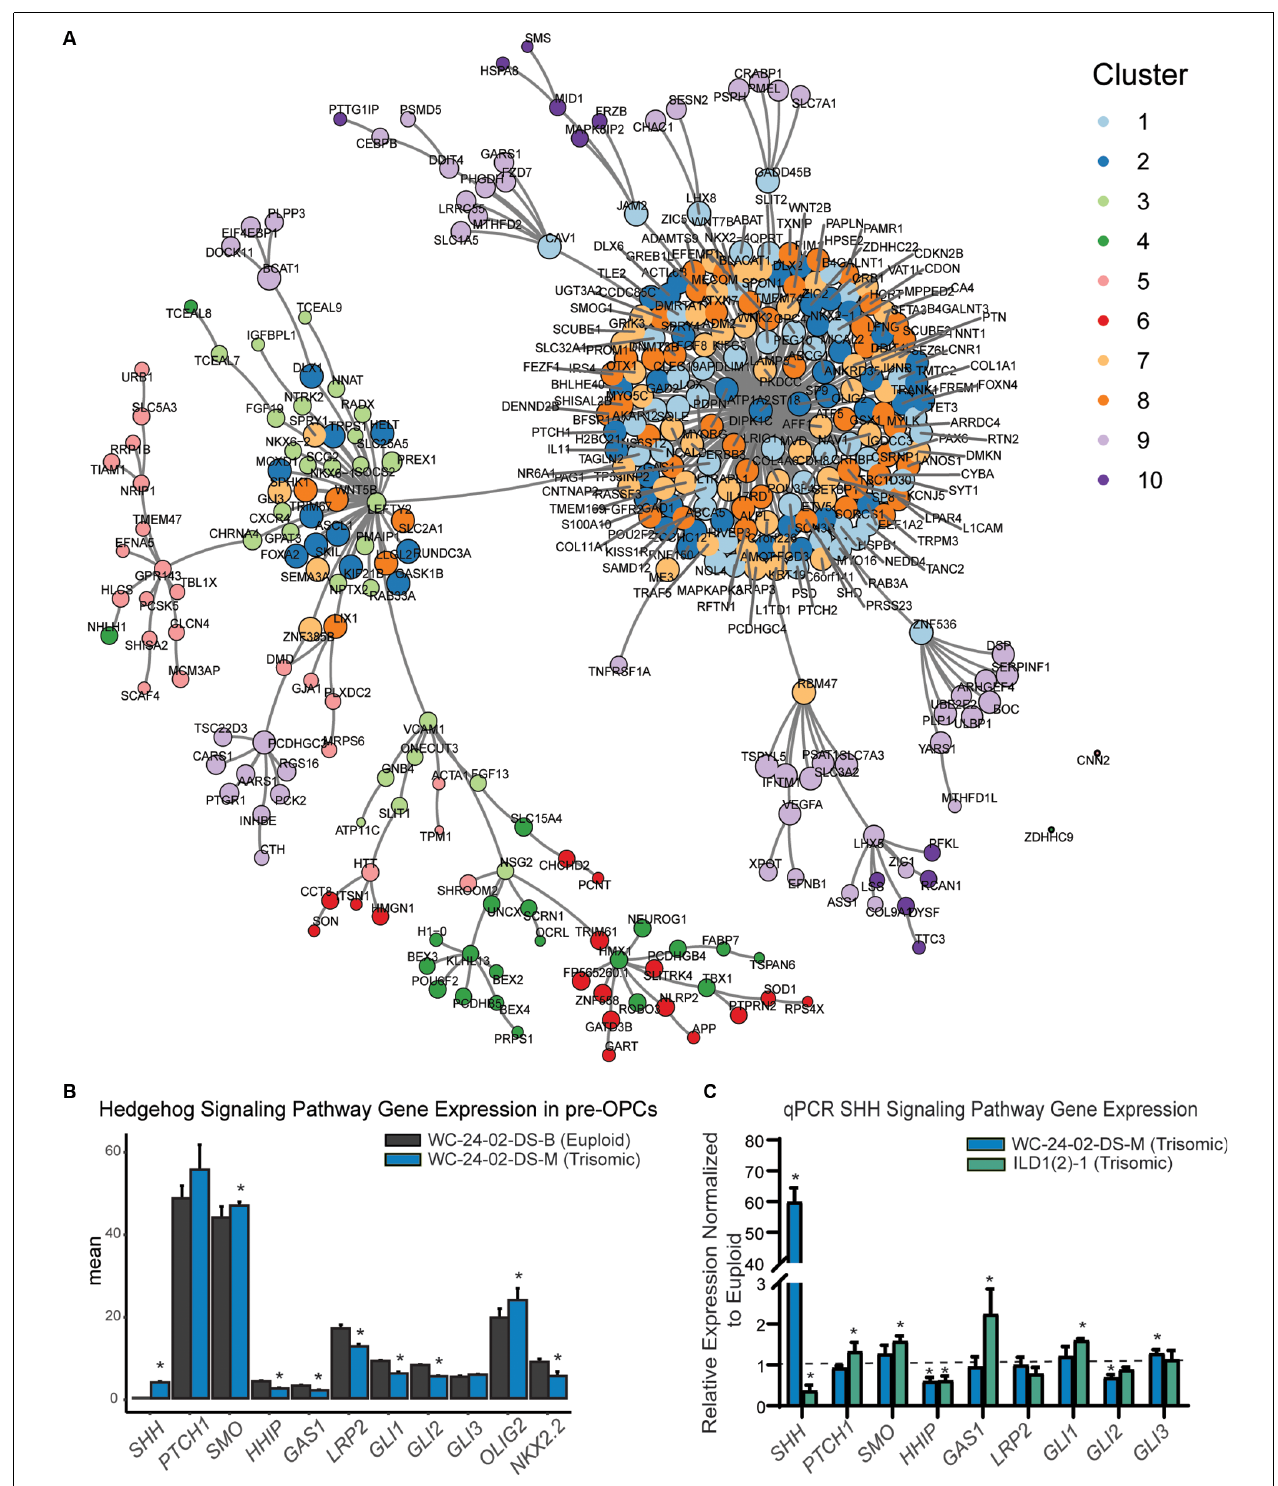
FIGURE 6 | SHH pathway dysregulation in trisomic NPCs. (A) Pairwise correlation analysis between the 1,000 DEX genes shows that gene clusters whose expression is primarily driven by differentiation day are tightly correlated in the center of the network. (B) Closer examination of genes in the RNA-seq dataset shows that there are significant differences in SHH signaling pathway expression in the trisomic tNPCs. (C) qRT-PCR validation of the SHH pathway genes from the RNA-seq dataset show dysregulation in both trisomic lines (WC ts and ILD ts ) of differentiated tNPCs compared to their euploid controls (WC eu and ILD eu ). n = 3–5 independently cultured wells. Data are shown as mean ± SD. * p -value < 0.05 with specific values in text.